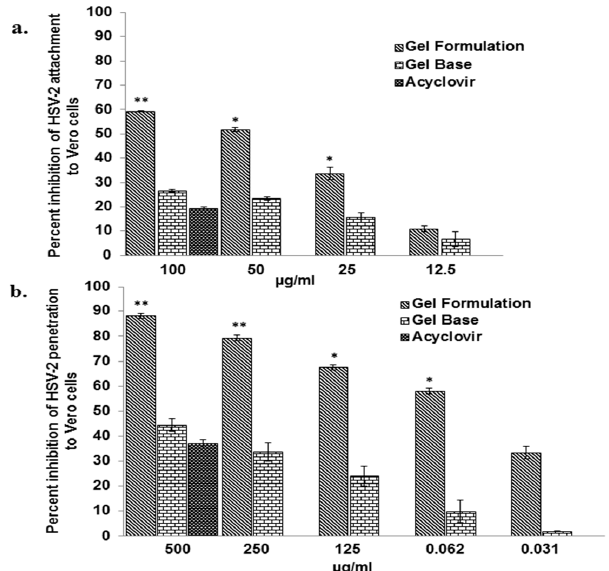
Figure 3 . Effect of the gel formulation on the attachment and penetration of HSV-2 to the Vero cells.